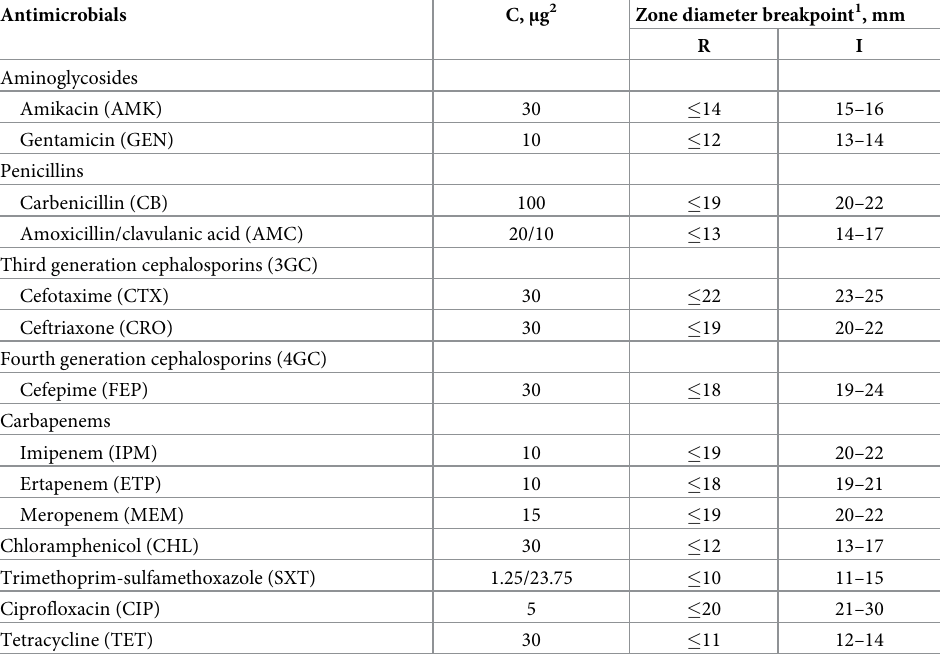
Table 1. Antimicrobial agents tested, their concentrations and clinical break points of the zone diameter used in the AST. Antimicrobials C, μ g